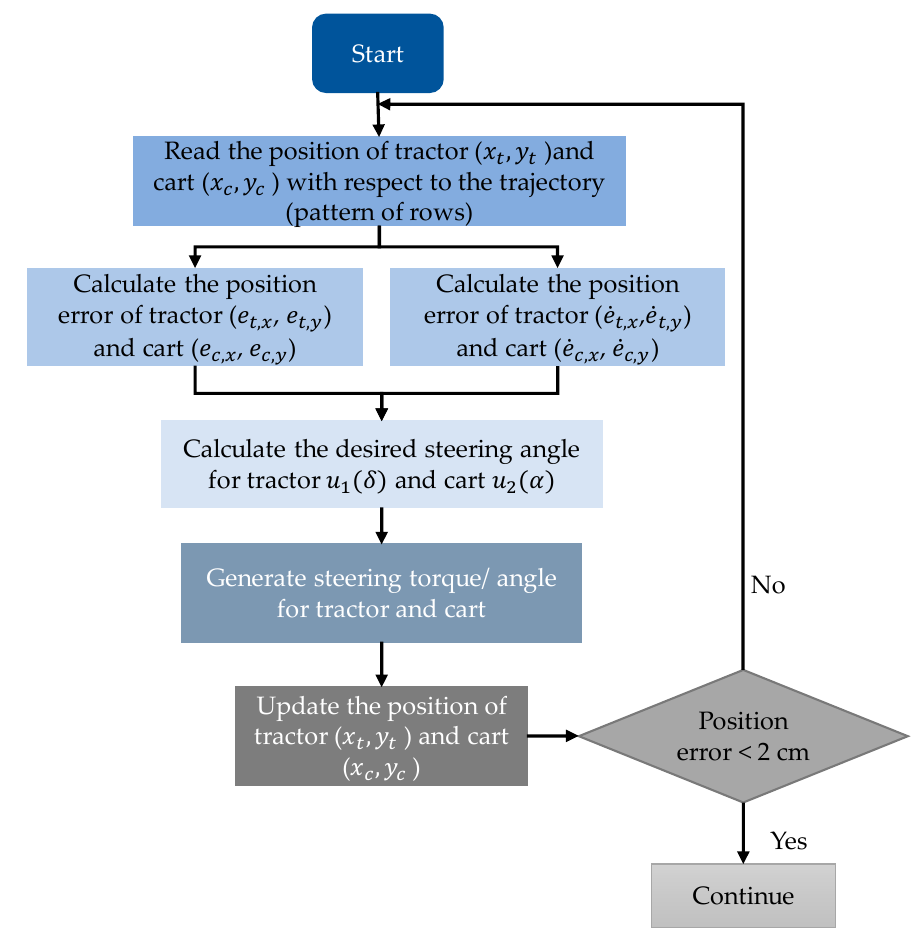
Figure 4. Flow chart of position control procedure for the tractor-cart system for path tracking.